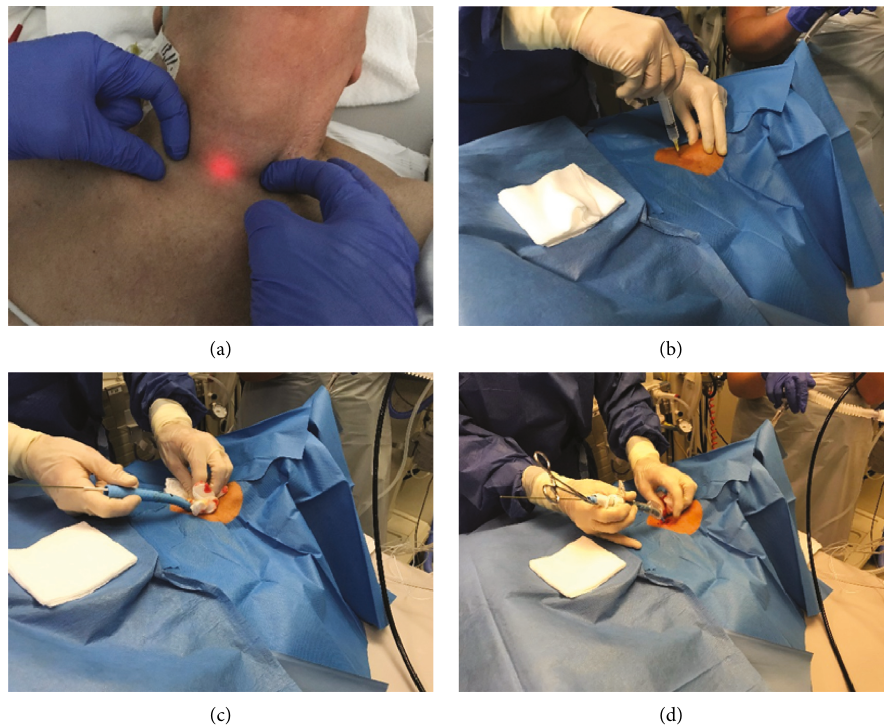
Figure 1: Stages of percutaneous dilatational tracheostomy. Diaphanoscopy (a), needle insertion midline, beneath second or third cartilage (b), dilatation with the Blue Rhino ® (c), and insertion of the cannula